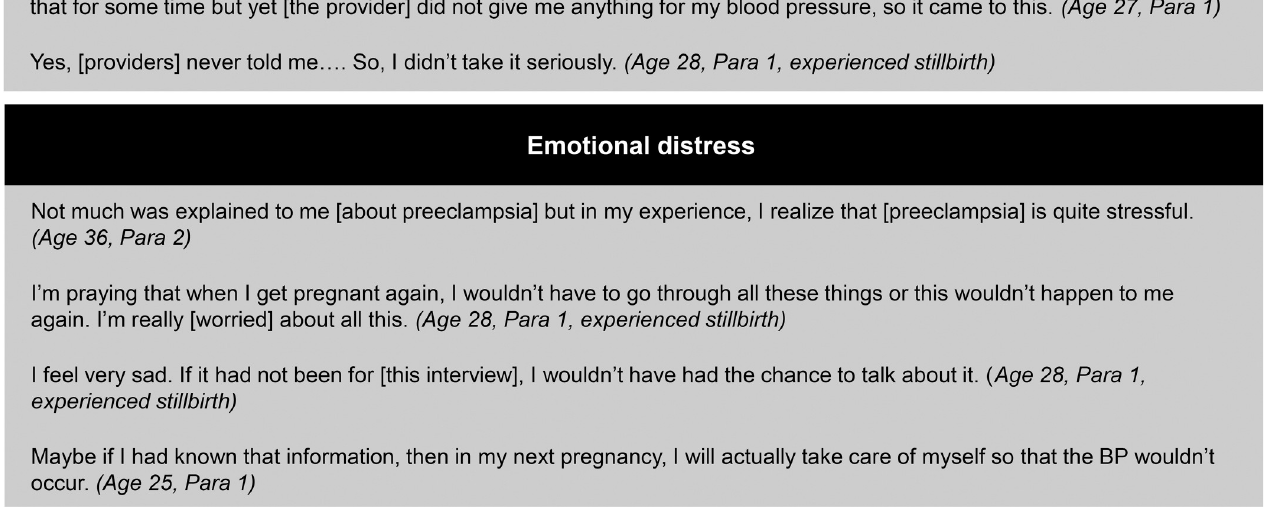
Fig 1. Representative quotations illustrating global